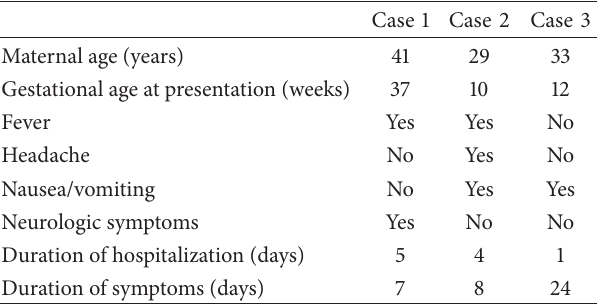
Table 1: Selected characteristics of West Nile virus infection during pregnancy at a single